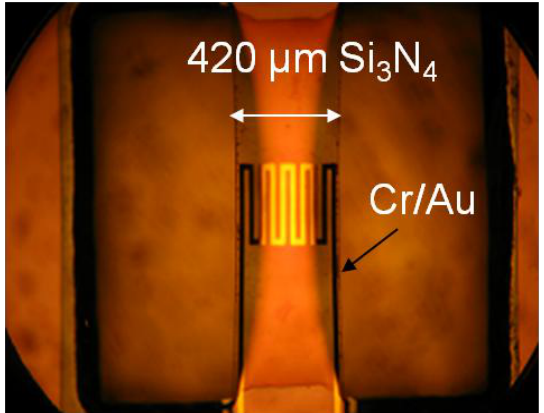
Figure 3. Optical micrograph of the top view of a bridge-type Pirani gauge. The silicon nitride bridge dimensions are 420 µm × 1,250 µm.